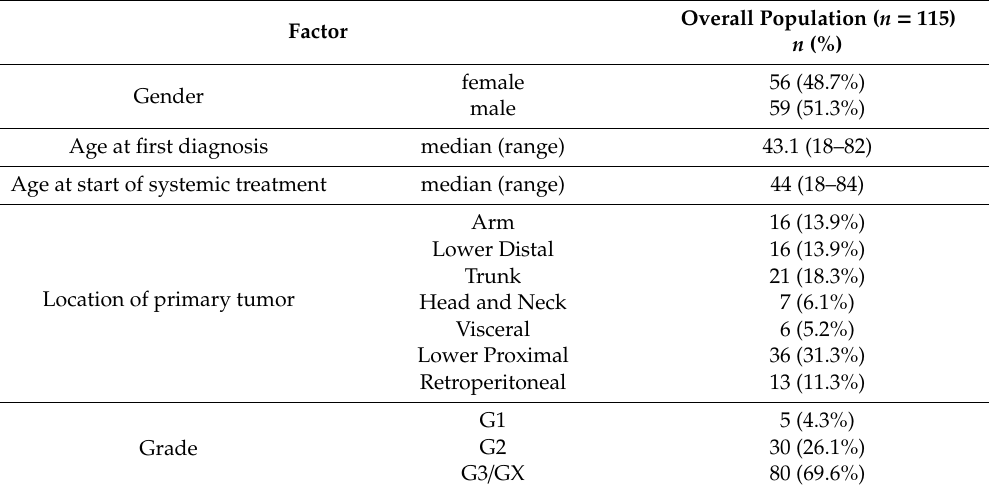
Table 1. Clinicopathological characteristics of